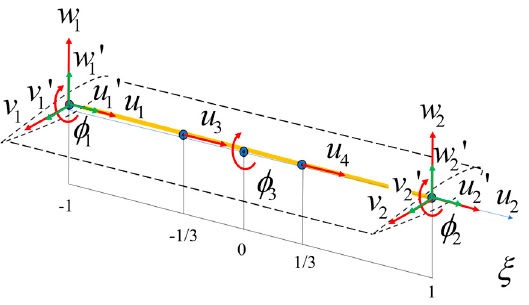
Figure 3. The arrangement of nodes and DOFs of the element of the ECR blade.